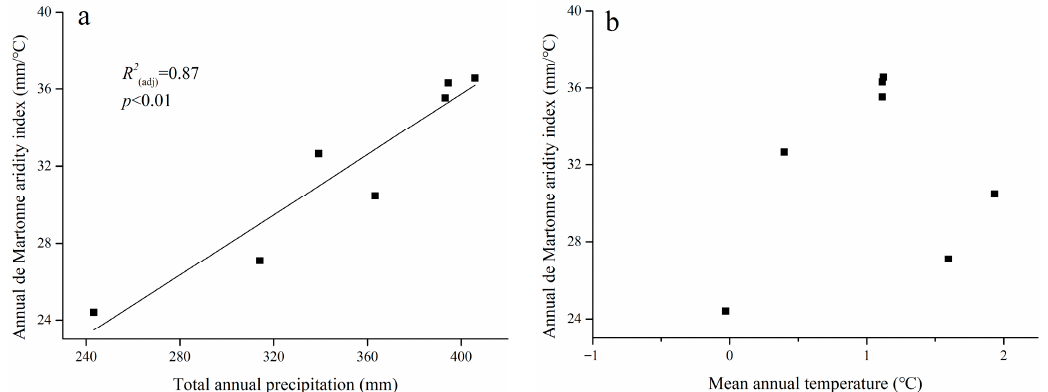
Figure 2. The relationships between the annual de Martonne aridity index and total annual precipitation ( a ) and mean annual temperature ( b ) for the sites below 3000 m a.s.l.